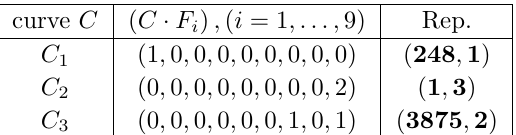
Table 2 . The rational ( (cid:0) 1)-curves giving rise to spin 0 BPS states on the CFD of the SCFT with G F = E 8 (cid:2)